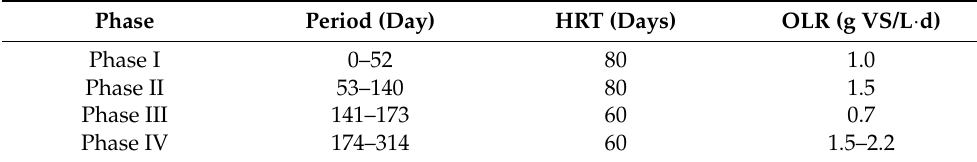
Table 2. Overview of the reactor’s setup during the AD experiment with IF_PP. Phase Period (Day) HRT